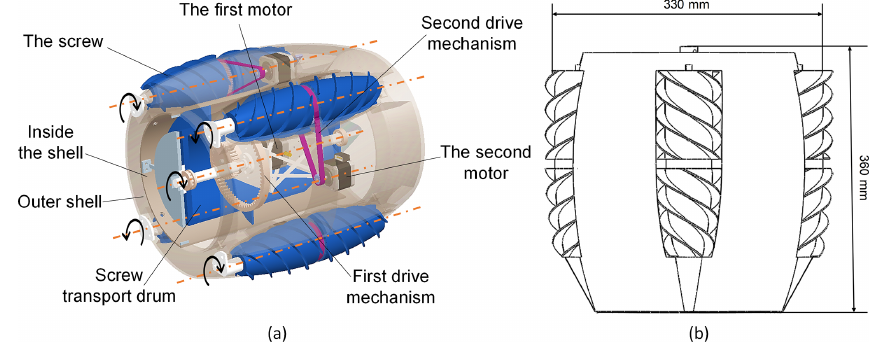
Figure 2. Schematic diagram of the drill-in granary grain condition detector. (a) Internal drive structure. (b) Approximate geometric dimen- sion.